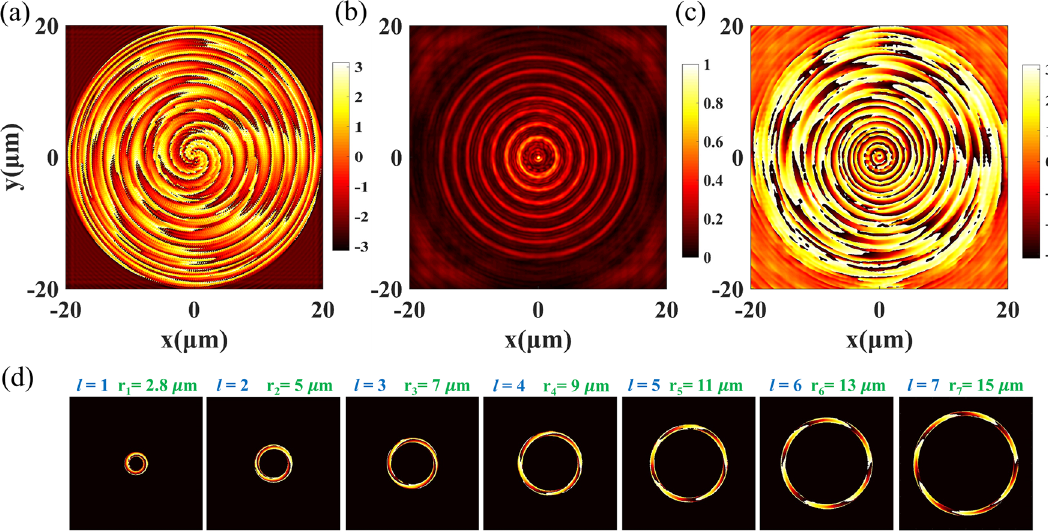
Figure 6. The coaxial array of Q-PV. ( a ) The designed phase distribution of the coaxial array; ( b ) The light field distribution in the focal plane; ( c ) The phase distributions in the focal plane; ( d ) The phase information of each Q-PV